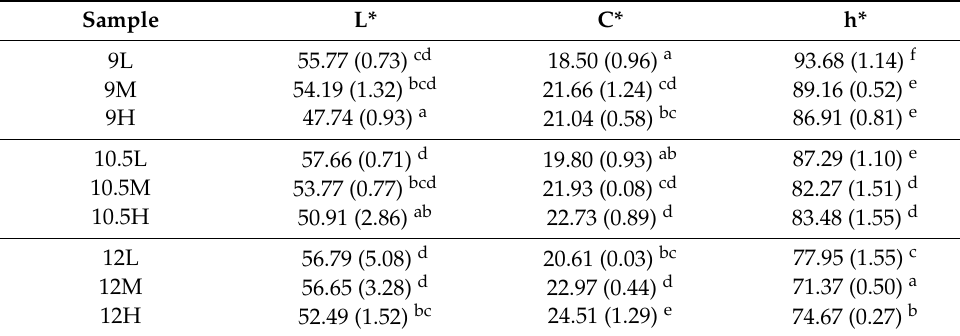
Table 2. Color parameters of the